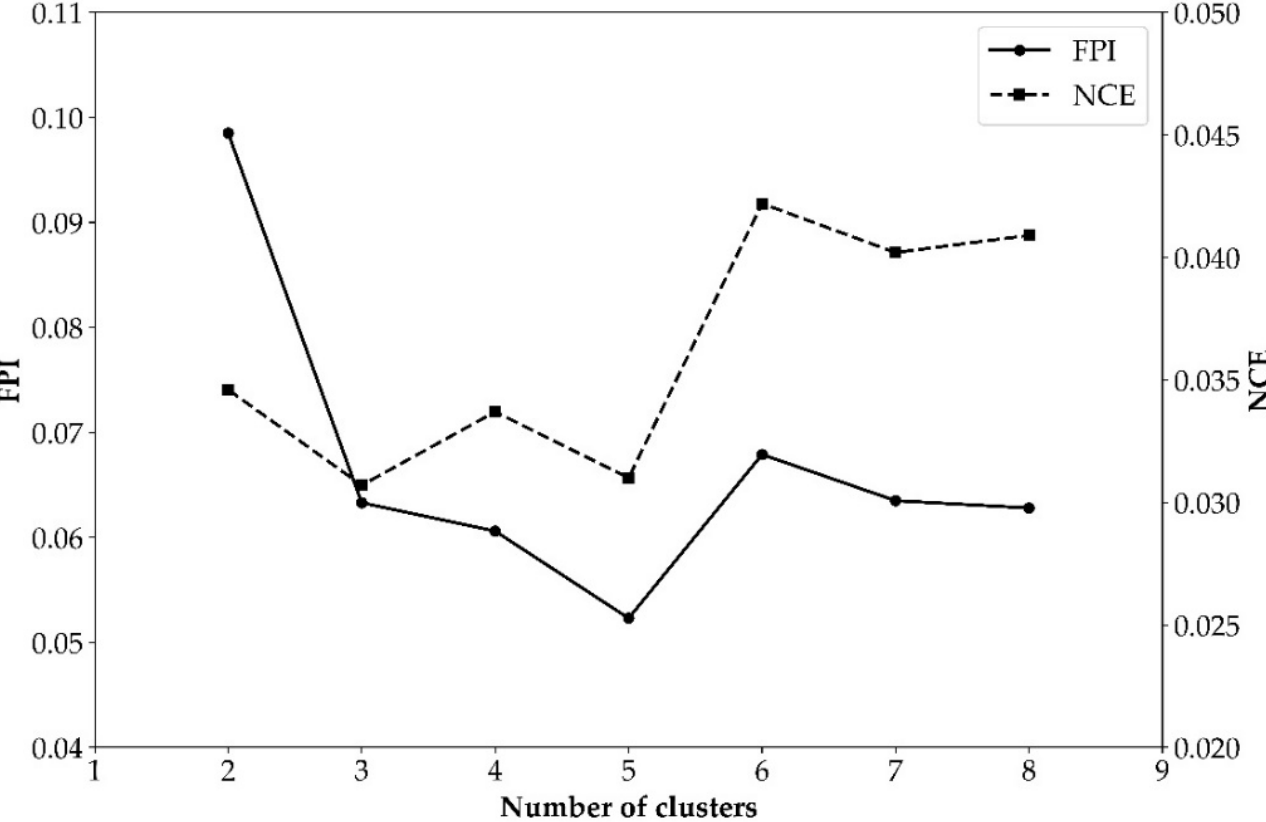
Figure 10. Fuzzy performance index (FPI) and normalized classification entropy (NCE) calculated to determine the optimum number of clusters for the study area.